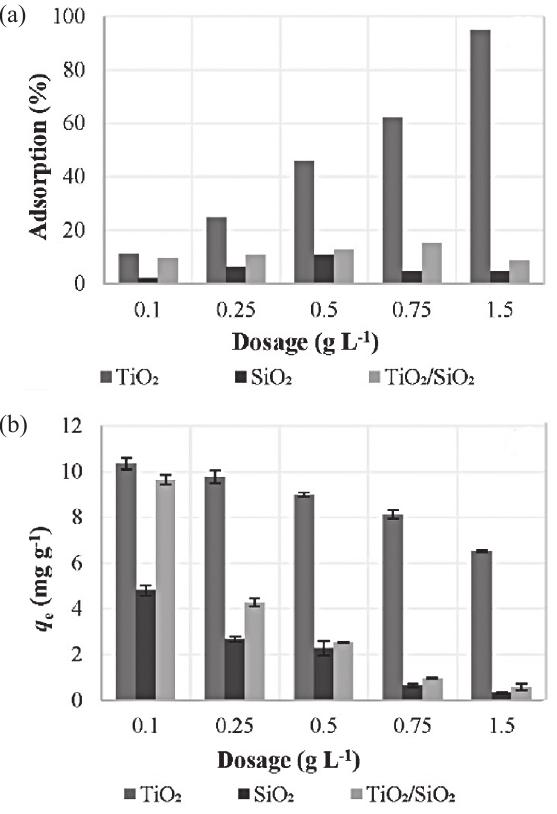
Fig. 5 – Change in (a) adsorption percentage, and (b) uptake of cefdinir with respect to adsorbent dosage (C mg L –1 , T = 25 °C, pH =